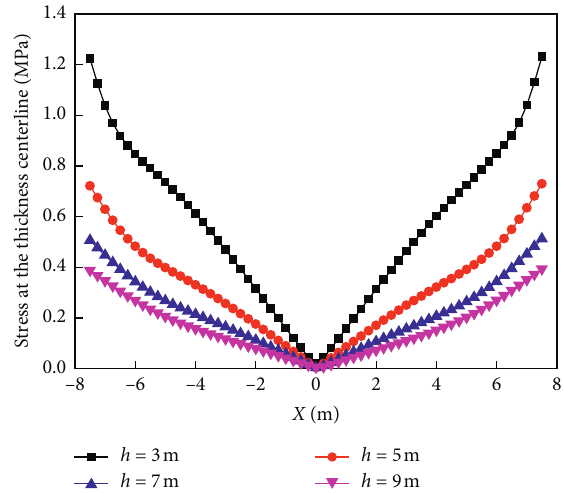
Figure 9: MSS distributions at the thickness centerline ( h /2) with different ARBBS thicknesses.